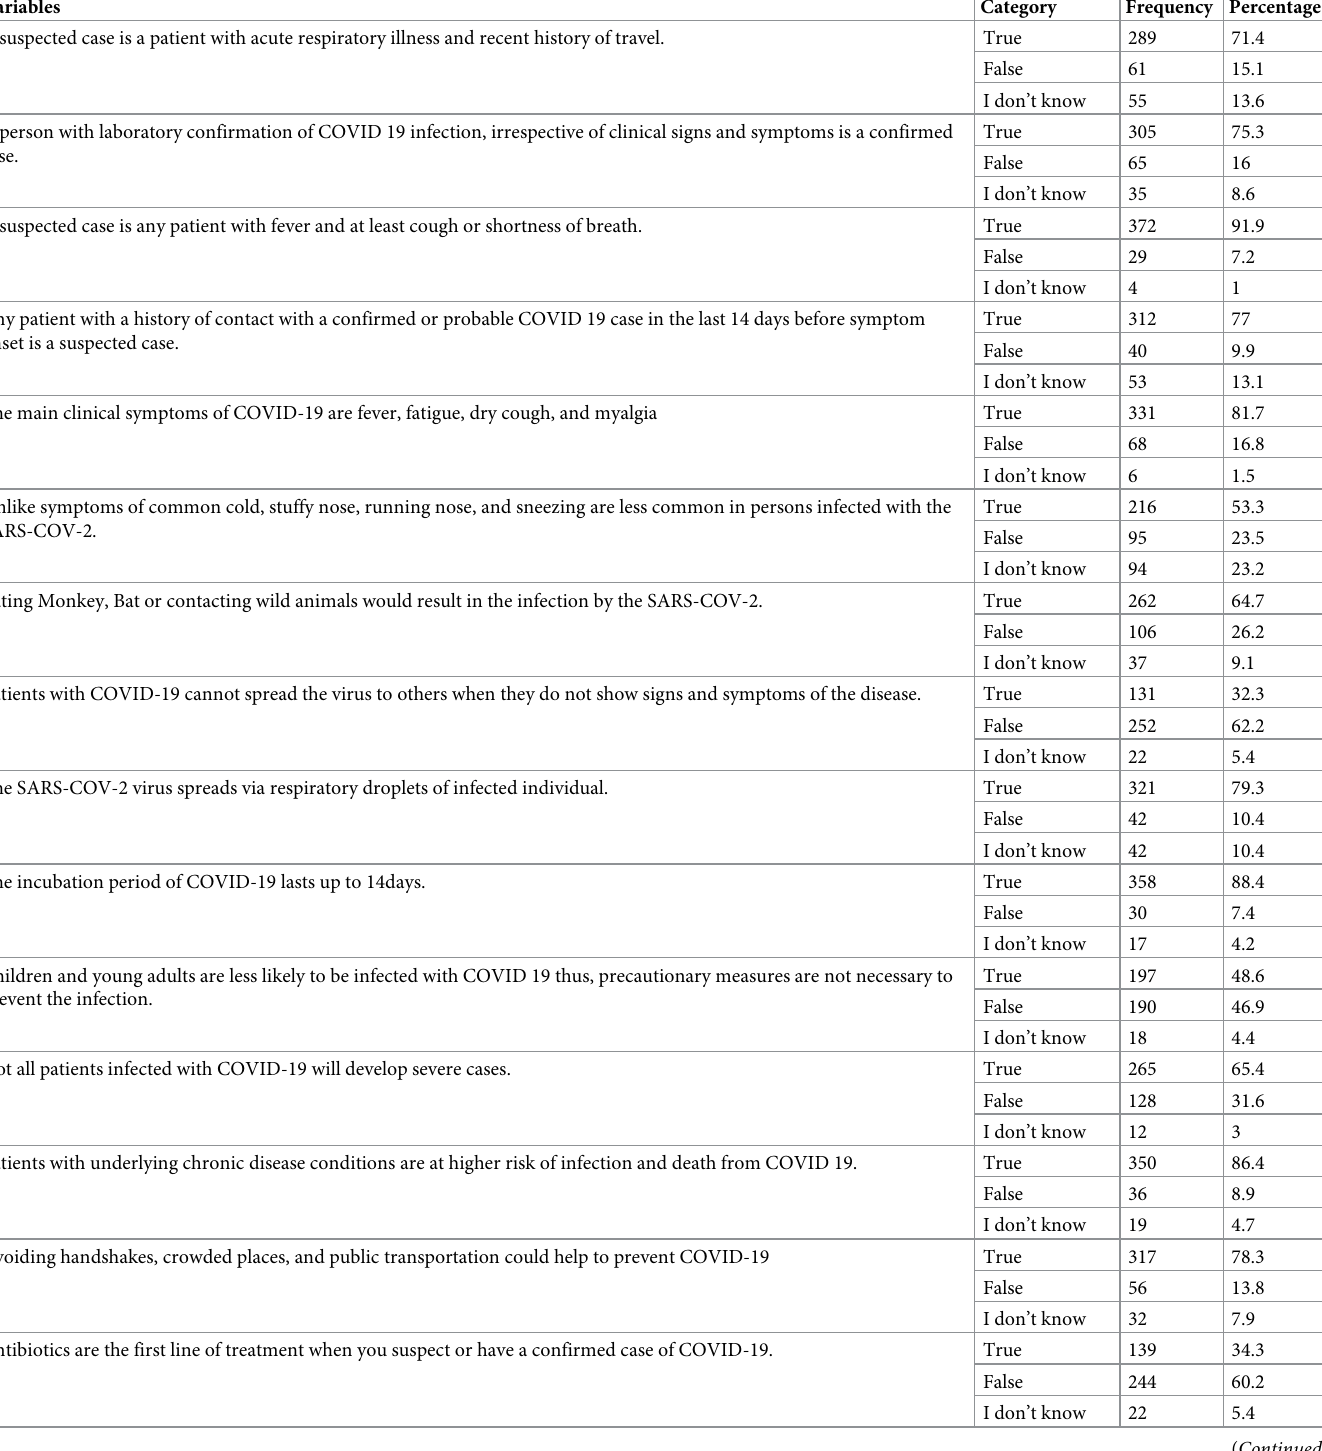
Table 3. COVID-19 knowledge of the HCWs working at hospitals of southwestern Ethiopia, 2021 (n =